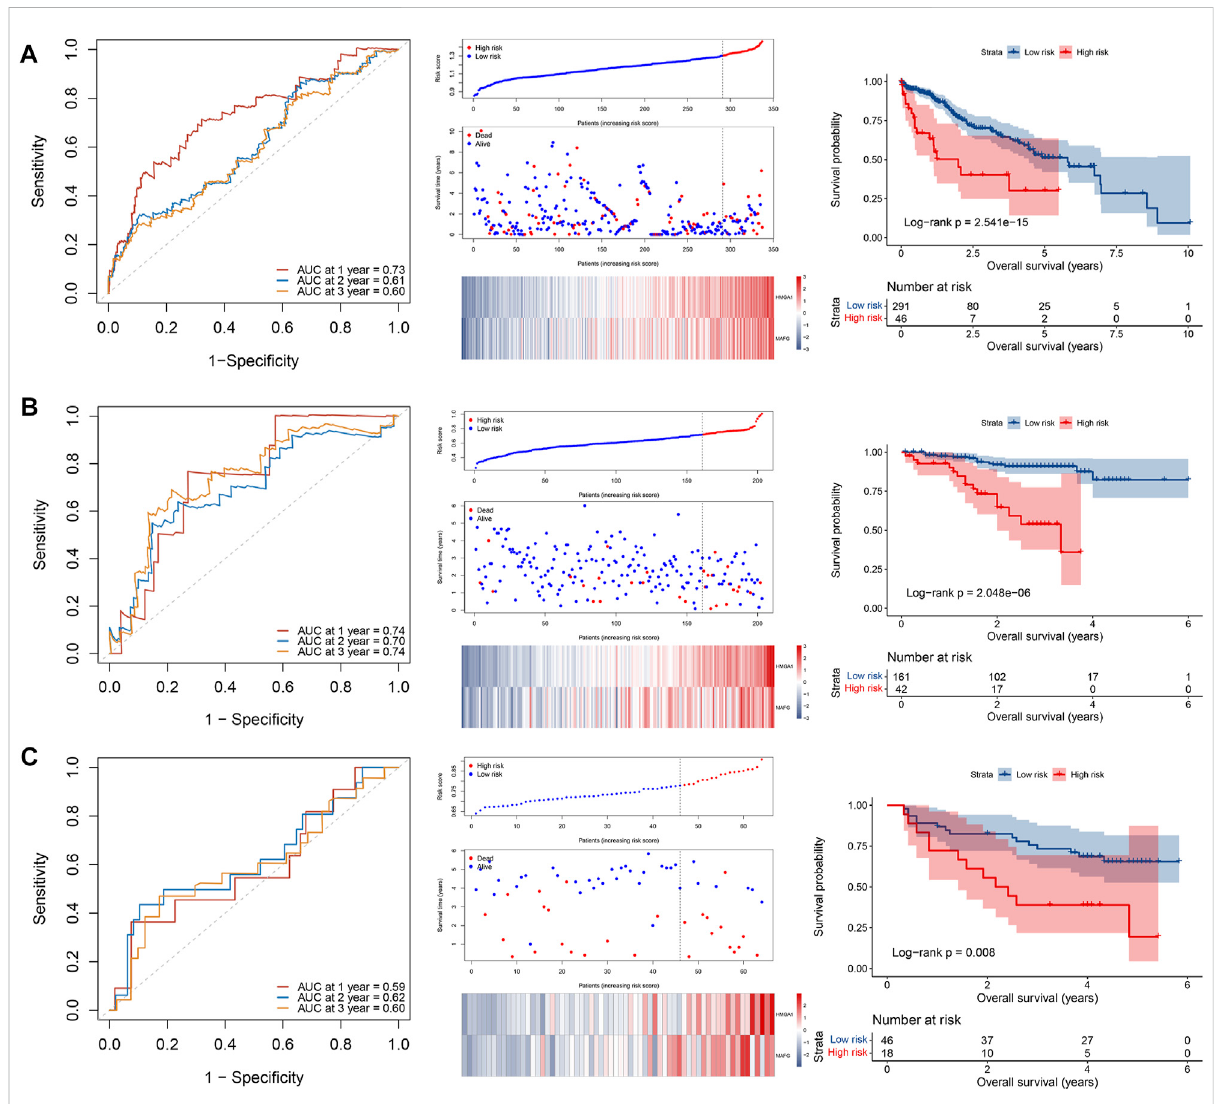
FIGURE 3 Construction and validation of a 2-TF prognostic signature. The ROC curve, distributions of the risk score and survival status, heatmap of expression pro fi les, and Kaplan – Meier curve of the 2-TF signature in the training set of TCGA cohort (A) , as well as in the validation sets of ICGC cohort (B) and GSE116174 cohort (C) . TF, transcription factor; AUC, area under the curve; ROC, receiver operating characteristic; TCGA, The Cancer Genome Atlas; ICGC, International Cancer Genome